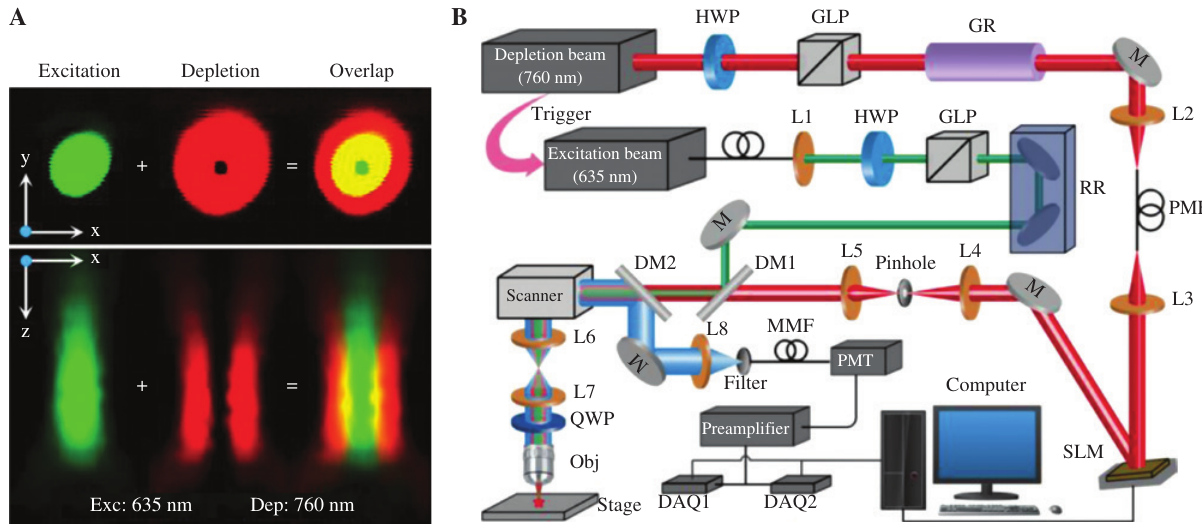
Figure 1: Principle and experiment system of STED microscopy. (A) Focal spots of the excitation beam and the depletion beam, and their overlap in both XY plane and XZ plane. (B) Schematic of the STED imaging system. L, lens; HWP, half wave plate; GLP, Glan-laser polarizer; GR, glass rod; RR, retro reflector; M, mirror; DM, dichroic mirrors; Obj, objective lens; QWP, quarter wave plate; SMF, single mode fiber; PMF, polarization maintaining fiber; MMF, multimode fiber; DAQ, data acquisition